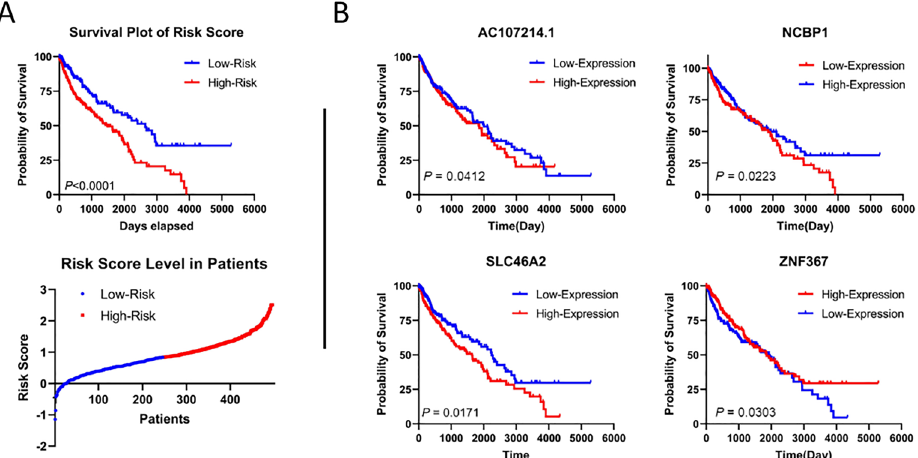
Figure 6. Classification of patients into two high and low-risk groups based on risk score model consisting of four genes and their survival rate. ( A ) The survival plot of high and low-risk patients based on median risk score and the risk score distribution of patients as a scatter plot. ( B ) The survival plot of each gene applied to compute the risk score based on each gene’s high and low expression levels, using their median as the cut-off value.